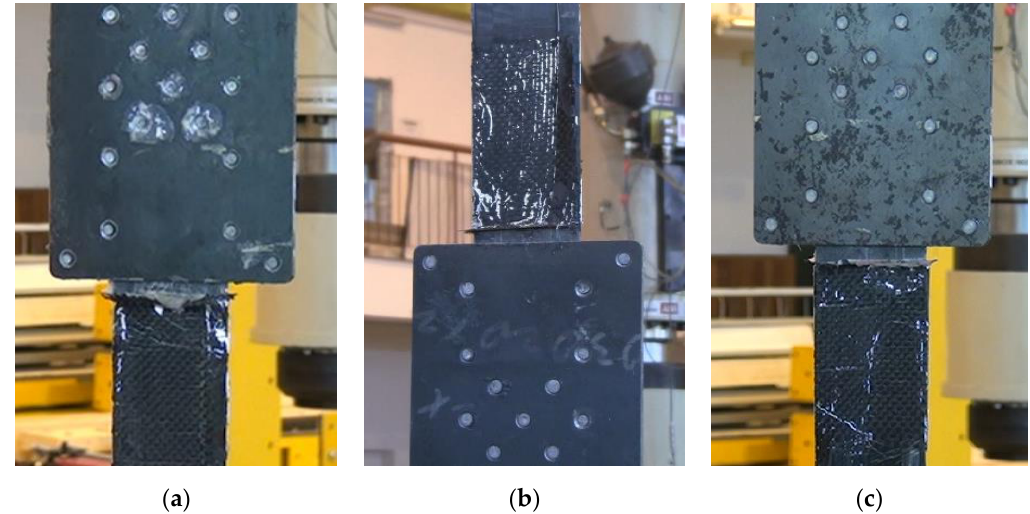
Figure 15. Failure mode of the subsequent specimens in the S2N series: ( a ) P1/S2N, ( b ) P2/S2N, ( c ) P3/S2N.